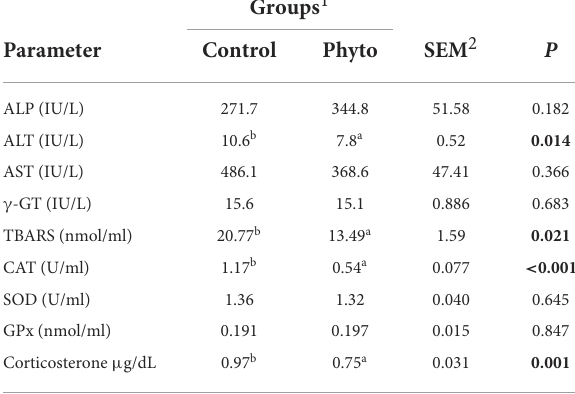
TABLE 2 Effect of dietary supplementation with PHYTO on laying hen performance.